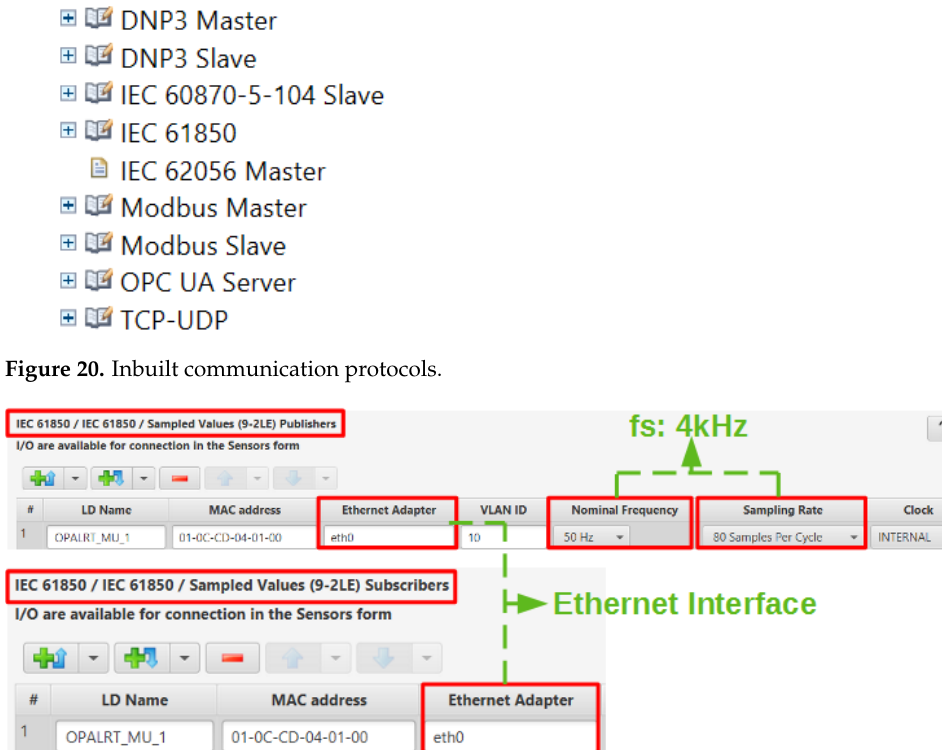
Figure 21. GUI for SV publishers and subscribers.